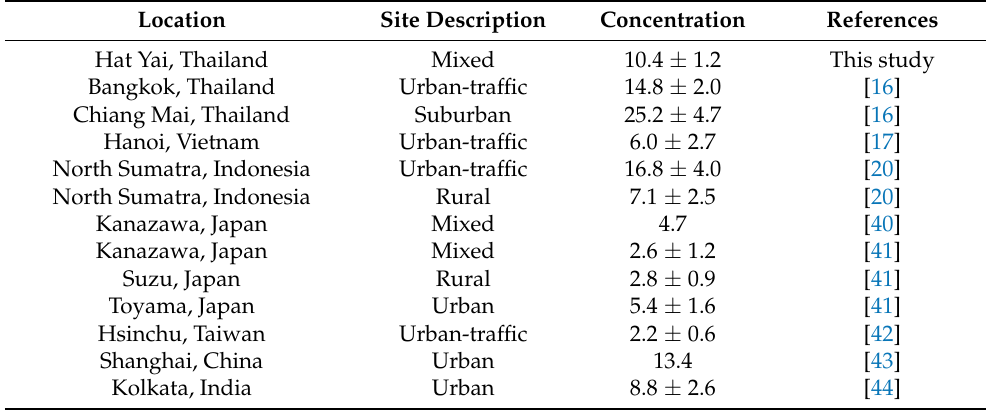
Table 2. Mass concentration of the PM 0.1 fraction at different locations in Asia ( µ g/m 3 ). Location Site